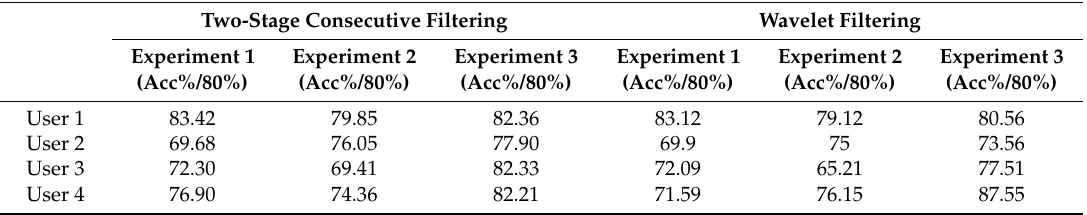
Table 9. Classification performance obtained from 3-axial acceleration sensors: filtering